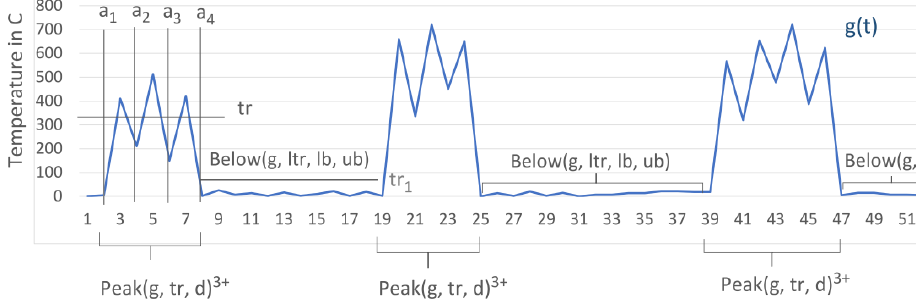
Figure 7. Periodic peaks in radiation corresponding to source